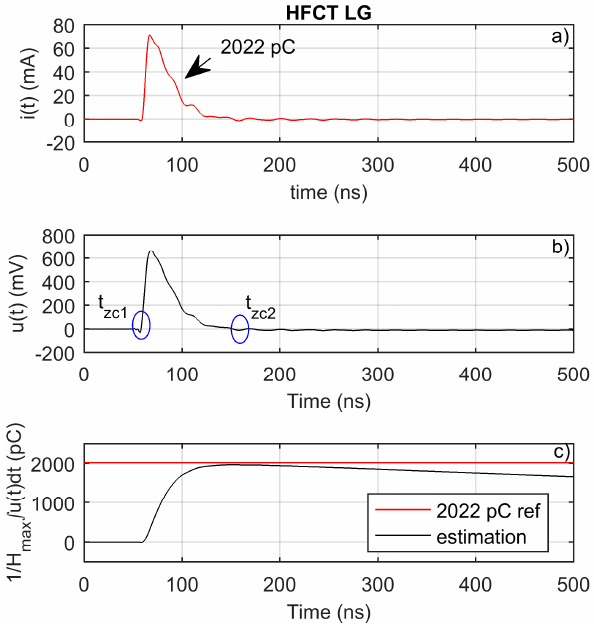
Figure 14. HFCT_LG: ( a ) injected calibrator current pulse; ( b ) measured pulse; ( c ) charge estimation using peak integration.